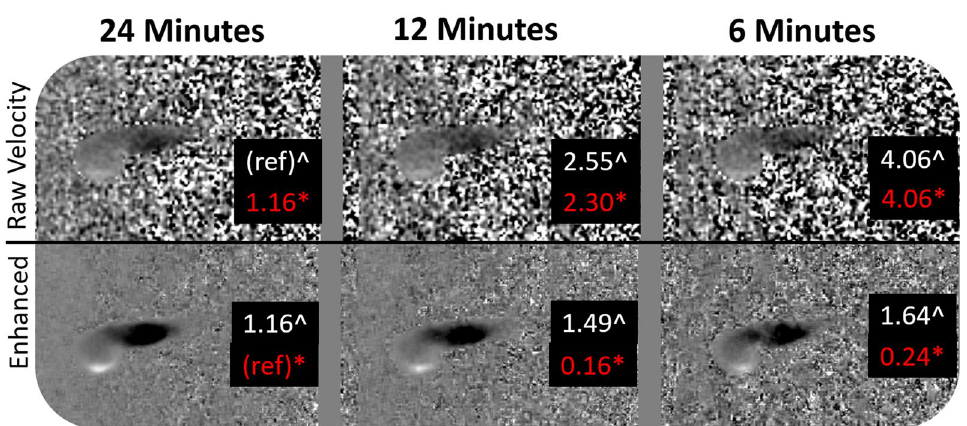
Figure 4. Physical phantom experiment output. A high resolution (24-min) 4D flow MRI procedure was performed on a blood vessel phantom. Subsequently, the data was sub-sampled into 12- and 6- minute scans. The trained neural network was applied to all three data sets (Enhanced). Data was first compared to the raw 24-min 4D flow scan data with a root-mean-square error (RMSE) metric (denoted by ^). The data was then compared to the “enhanced” data that was cleaned with the trained network (RMSE denoted by